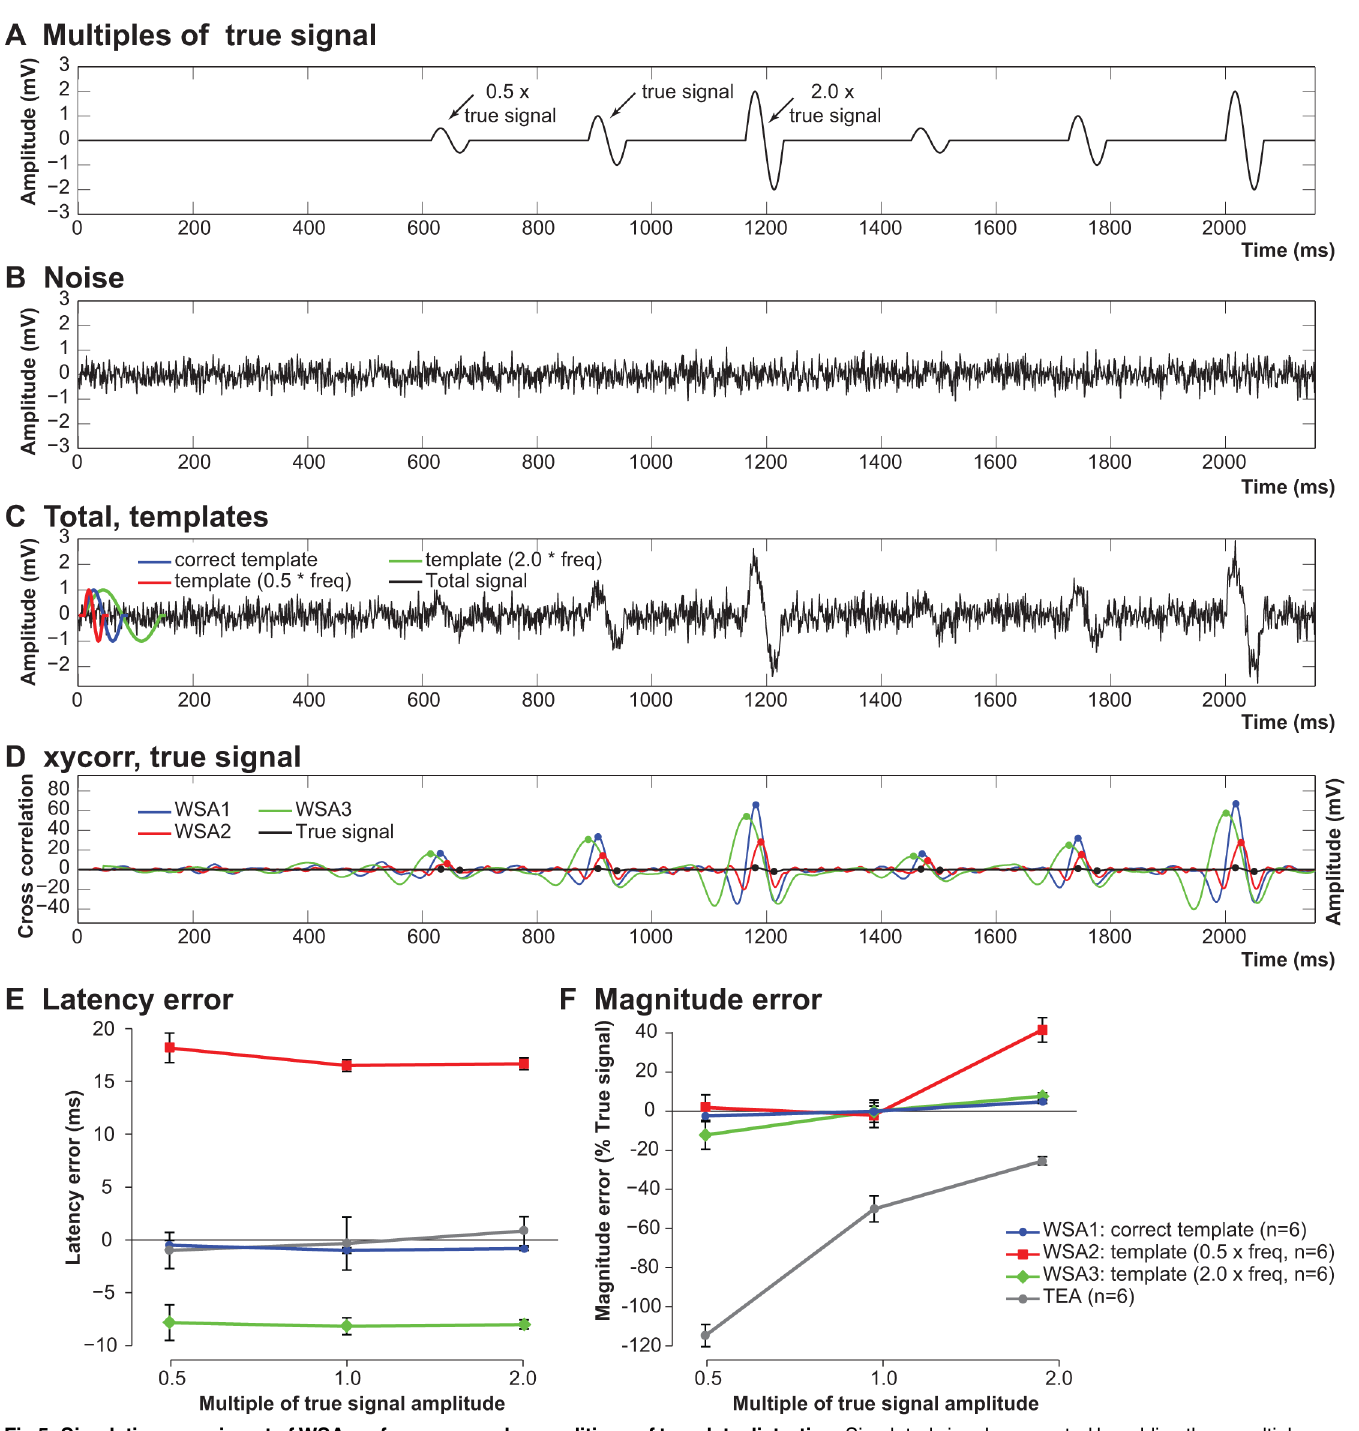
Fig 5. Simulation experiment of WSA performance under conditions of template distortion. Simulated signals generated by adding three multiples (0.5×, 1.0× and 2.0×) of a signal of interest (A, true signal) to noise (B), were used to derive a signal for analysis (C, total). WSA was applied using three templates; the correct one identical to 1.0× the true signal (C, blue), a template with double (C, red) and half (C, green) the frequency content of the correct template. Latency-corrected WSA outputs calculated from the cross-correlation sequence (xycorr) are shown (D) for each template (WSA1, blue, output with correct template; WSA2, red, template with double the correct frequency; WSA3, green, template with half the correct frequency). Overlayed to WSA outputs is the true signal, with the positive and negative peaks indicated (black dots) that reports the true peak-to-peak measurements for comparing the performance of WSA and TEA. Peak detection threshold at > 4× the standard deviation of the first 400 ms of each respective WSA output was used to automate peak